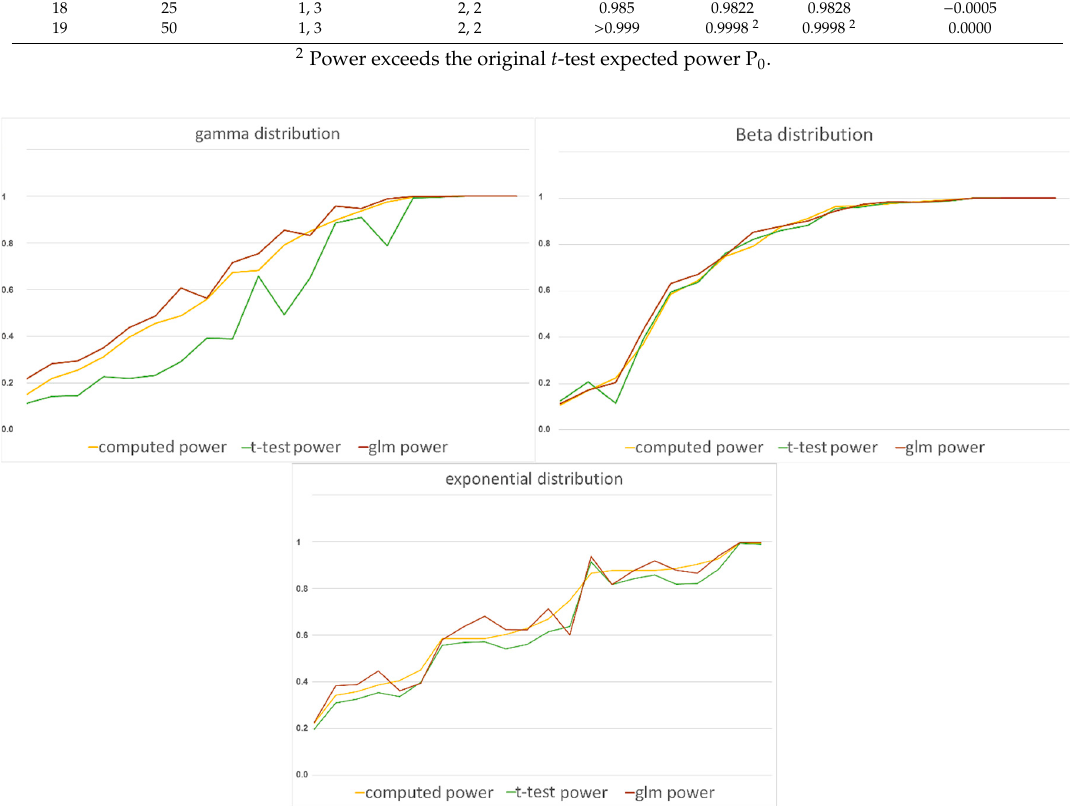
Table 5. Mean differences estimates’ values for original, log-transformed and GLM-fitted exponential distributed data.